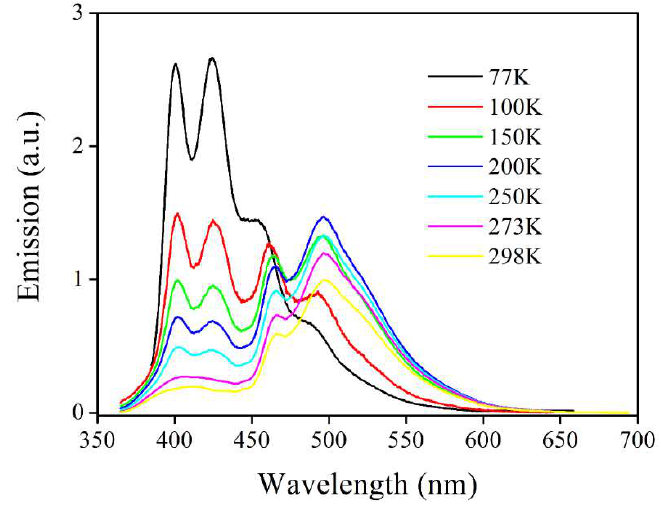
Figure 9. Temperature-dependent emission spectra of Ir(ppy) 2 (BPE) upon decreasing the temperature from 298 K to 77 K.